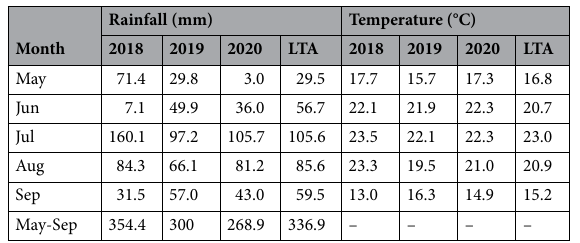
Table 2. The rainfall and monthly mean air temperature at the experimental site in 2018–2020 growing seasons. LTA the average value for the last 37 years (from 1981 to 2017).